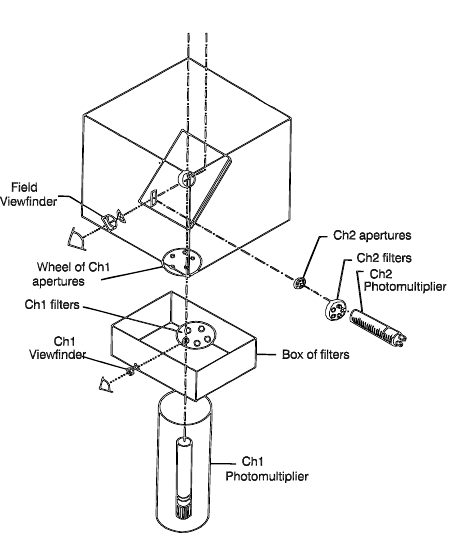
Fig. 1. The Texas two-channel high- speed photometer – principles of